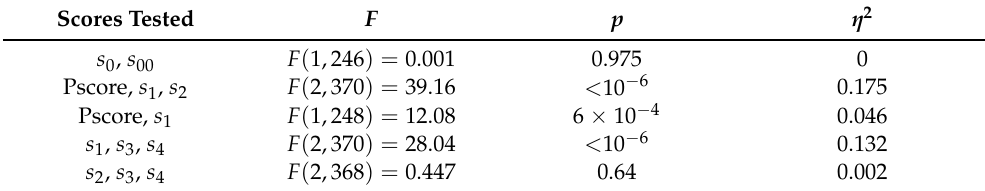
Table 3. Results of one-way ANOVAs to check statistical significance between AUC values on the test set for different groups of scoring functions, with PP as positive set and hsnLLPS as negative set. Scores Tested F p η 2 s 0 , s 00 F ( 1,246 ) =